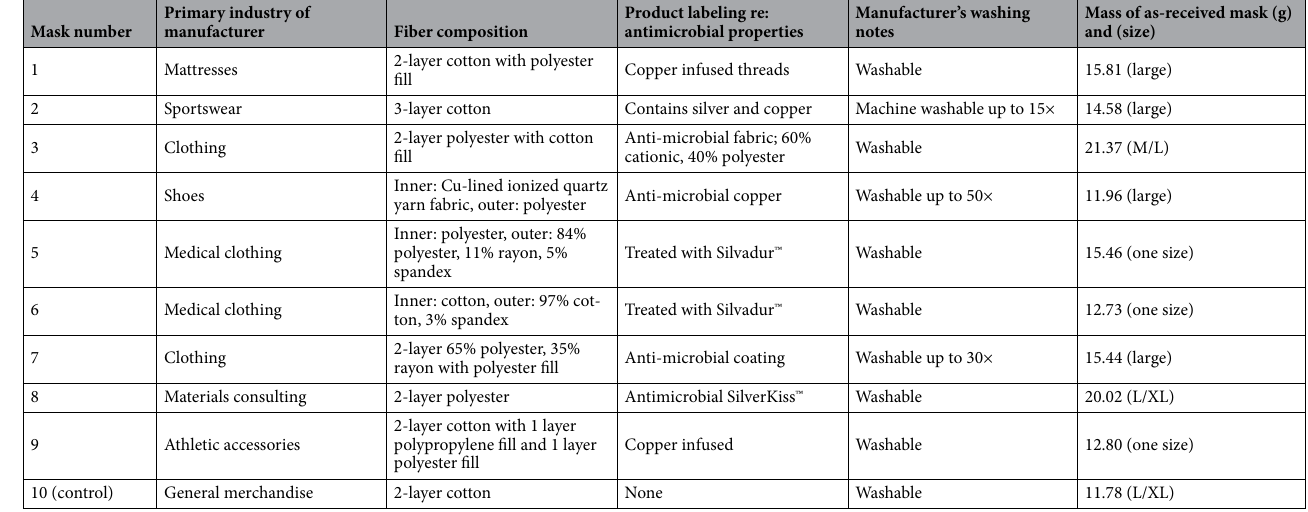
Table 1. Commercially available “antimicrobial” masks analyzed (for fiber composition, “inner” refers to fabric touching the mouth, “outer” to the fabric facing outwards, “fill” to any lining material between the inner and outer